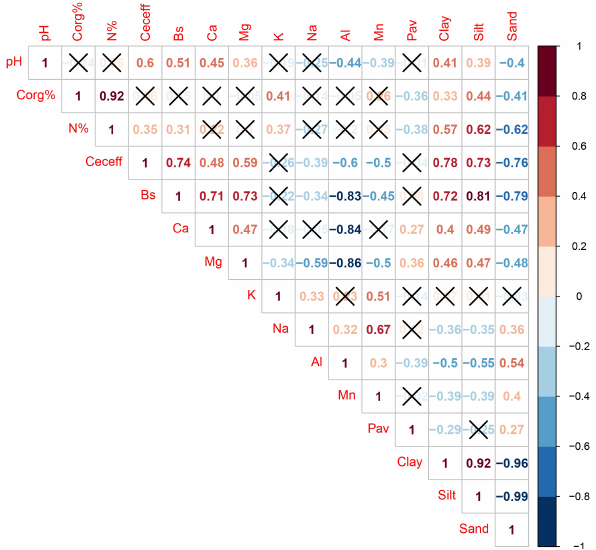
Figure 8. Pearson correlation matrix. Values with significance level p > 0.05 are crossed out.